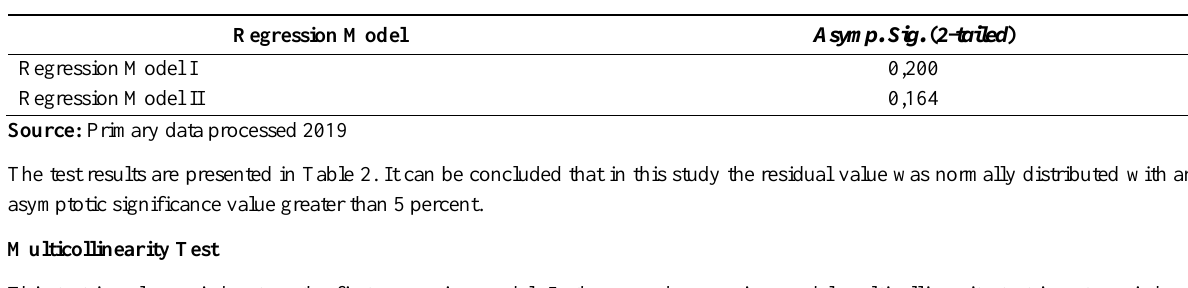
Table 2: Kolmogorov-Smirnov Test One Sample Test Results